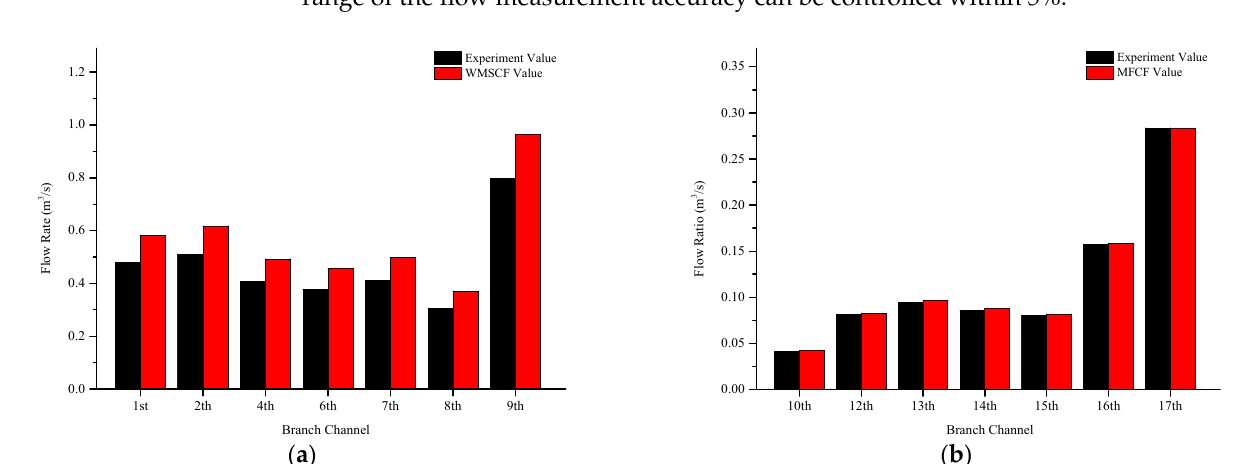
Figure 8. The relationship between the numerical results of the flow rate and the results of the calculation formula for water measurement specifications: ( a ) 1st to 9th branches under the conditions of opening degrees of 0.1, 0.2, 0.3, 0.4, 0.6, 0.8, and 1.0; ( b ) the 10th to 17th branches. “WMSCF” represents the water measurement specification calculation formula, and “MFCF” represents the modified flow calculation formula.